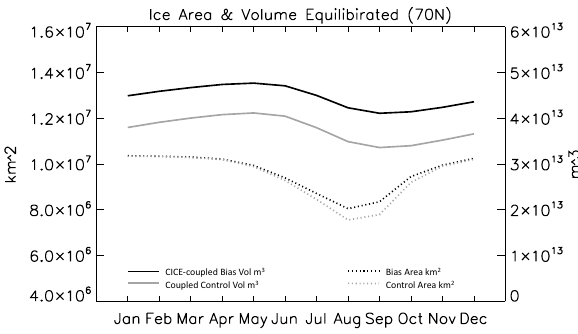
Fig. 5. Arctic sea ice volume and extent for control run and CCSM bias experiment. Restricted to north of latitude 70 ◦ N.